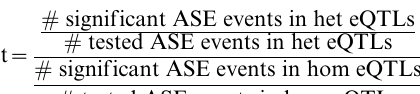
Figure S1 Reproducibility across all samples between